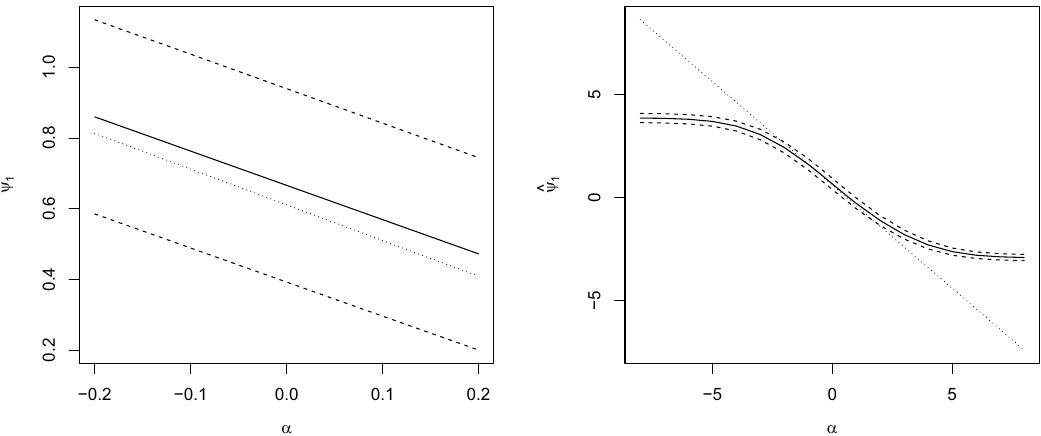
Figure 1: The estimated marginal causal log odds ratio ( solid lines ) and log risk ratio ( dotted lines ) for behavior pattern and CHD together with pointwise 95% con fi dence limits ( dashed lines ) for the marginal causal log odds ratio, as functions of the sensitivity parameter α